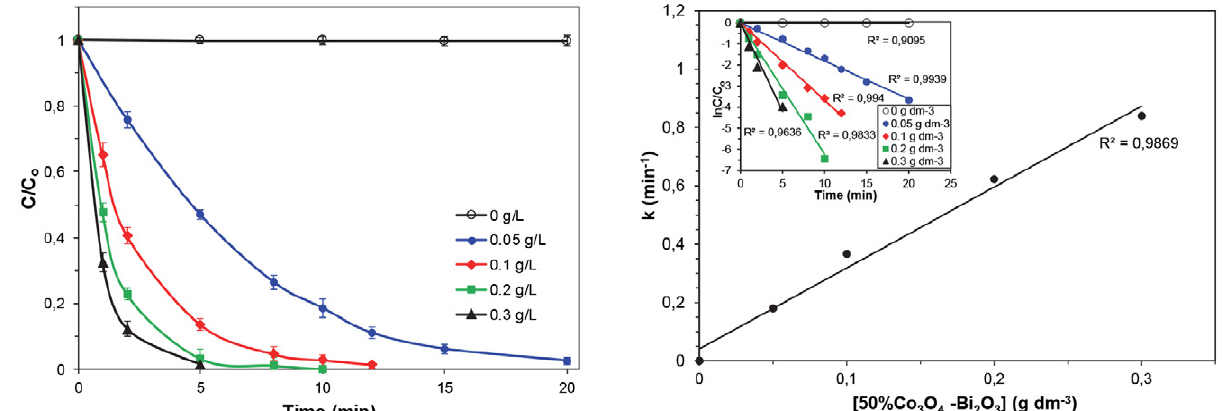
Fig. 11. Catalytic performance of 50%Bi 2 O 3 -Co 3 O 4 at various dossages in the presence of PMS and AO7: (a) AO7 degradation; (b) AO7 degradation kinetics. Reaction conditions: [AO7] o = 50 mg/L; [PMS]/[AO7] = 6; initial pH = 3.04; T = 293 K.